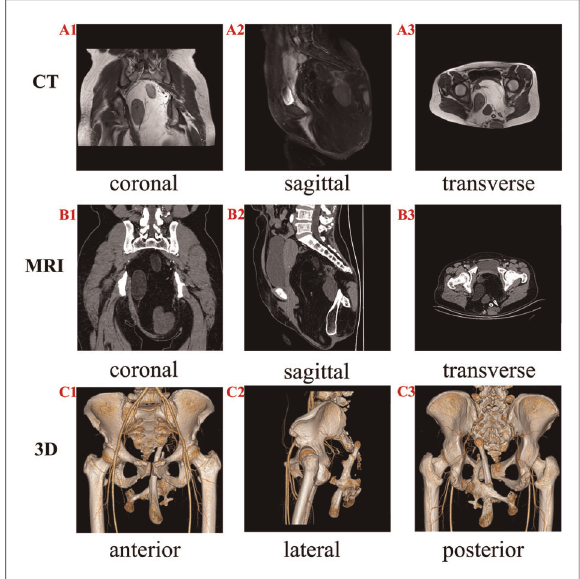
FIGURE 1 Magnetic resonance imaging (MRI) and 3D computed tomography (CT) of the patient. ( A1 – A3 ) CT showing different views of the teratoma. A huge space-occupying lesion exhibiting different densities can be observed in the pelvic cavity. A clear boundary is observed between the teratoma and pelvis. ( B 1 – B 3) MRI showing various views of the teratoma. The massive sacrococcygeal multiloculated lesion comprises a large amount of fat, sebaceous material, and long bone. ( C 1 – C 3) Various 3D views of the bone reconstruction based on CT; the 3D reconstruction allowed the visualization of the spatial positions of the bones within the teratoma as well as the lesion ’ s relationship with the